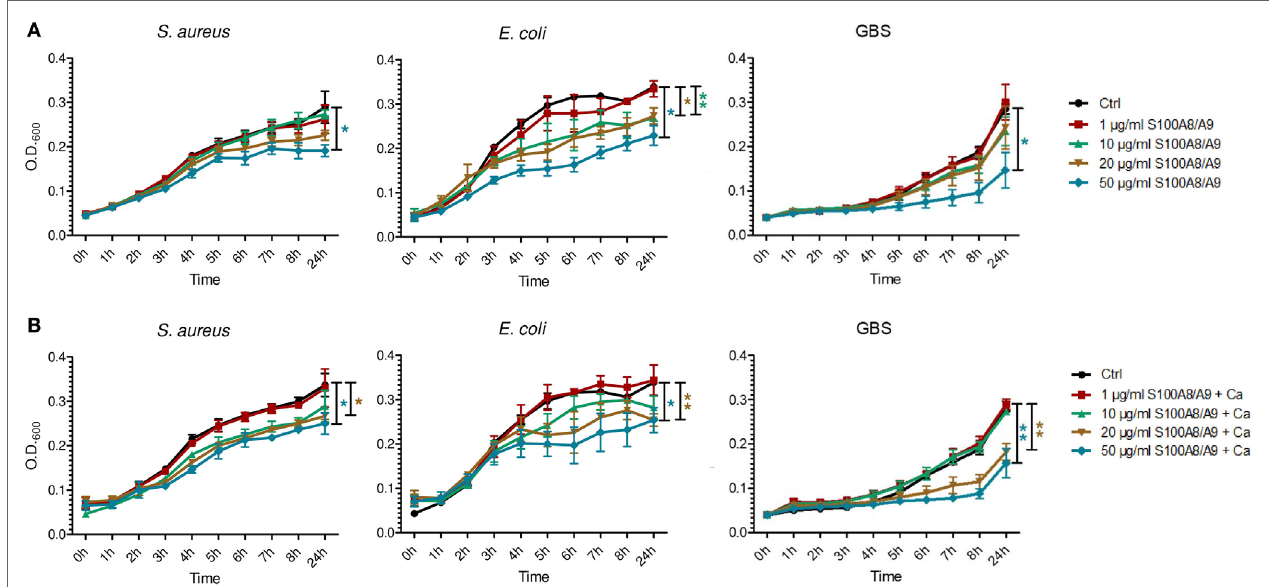
FigUre 3 | S100A8/A9 exerts antimicrobial activity at concentrations detectable in breast milk. Staphylococcus aureus , Escherichia coli , and group B streptococci (GBS) were grown at indicated concentrations of S100A8/A9 in the absence (a) and presence of 0.5 mM Ca (B) . OD 600 values over time were plotted as mean ± SEM. * p < 0.05 and ** p < 0.05, t -test ( n =